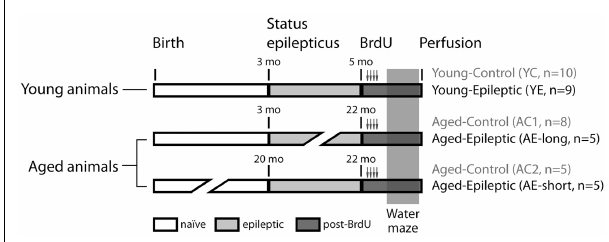
FIGURE 1 | Experimental groups . Rats were treated with pilocarpine to induce status epilepticus, control rats received saline instead of pilocarpine. Bromodeoxyuridine (BrdU) was administered for 2days, starting 9days before perfusion. Spatial learning was evaluated by the latency to find a hidden platform in a water maze (WM). Production and survival of newborn cells in the subgranular zone of the granule cell layer were measured through counting of BrdU and doublecortin (DCX) labeled cells, 24h after the last day of theWM task.